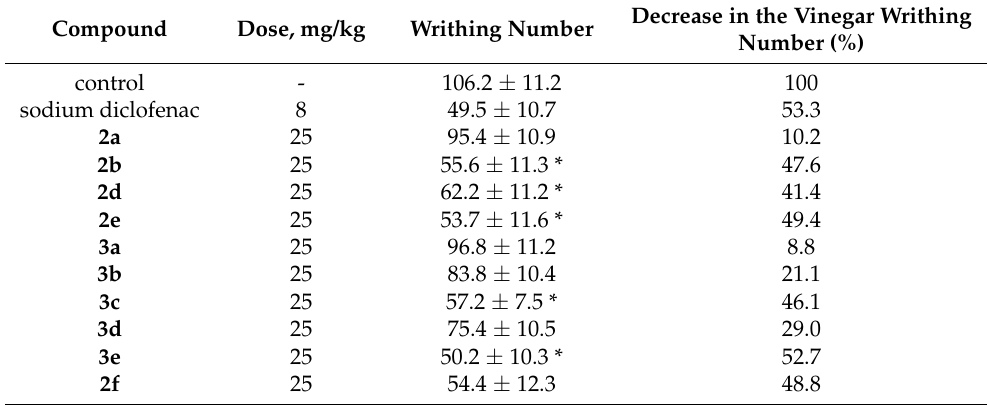
Table 5. Analgesic activity of test